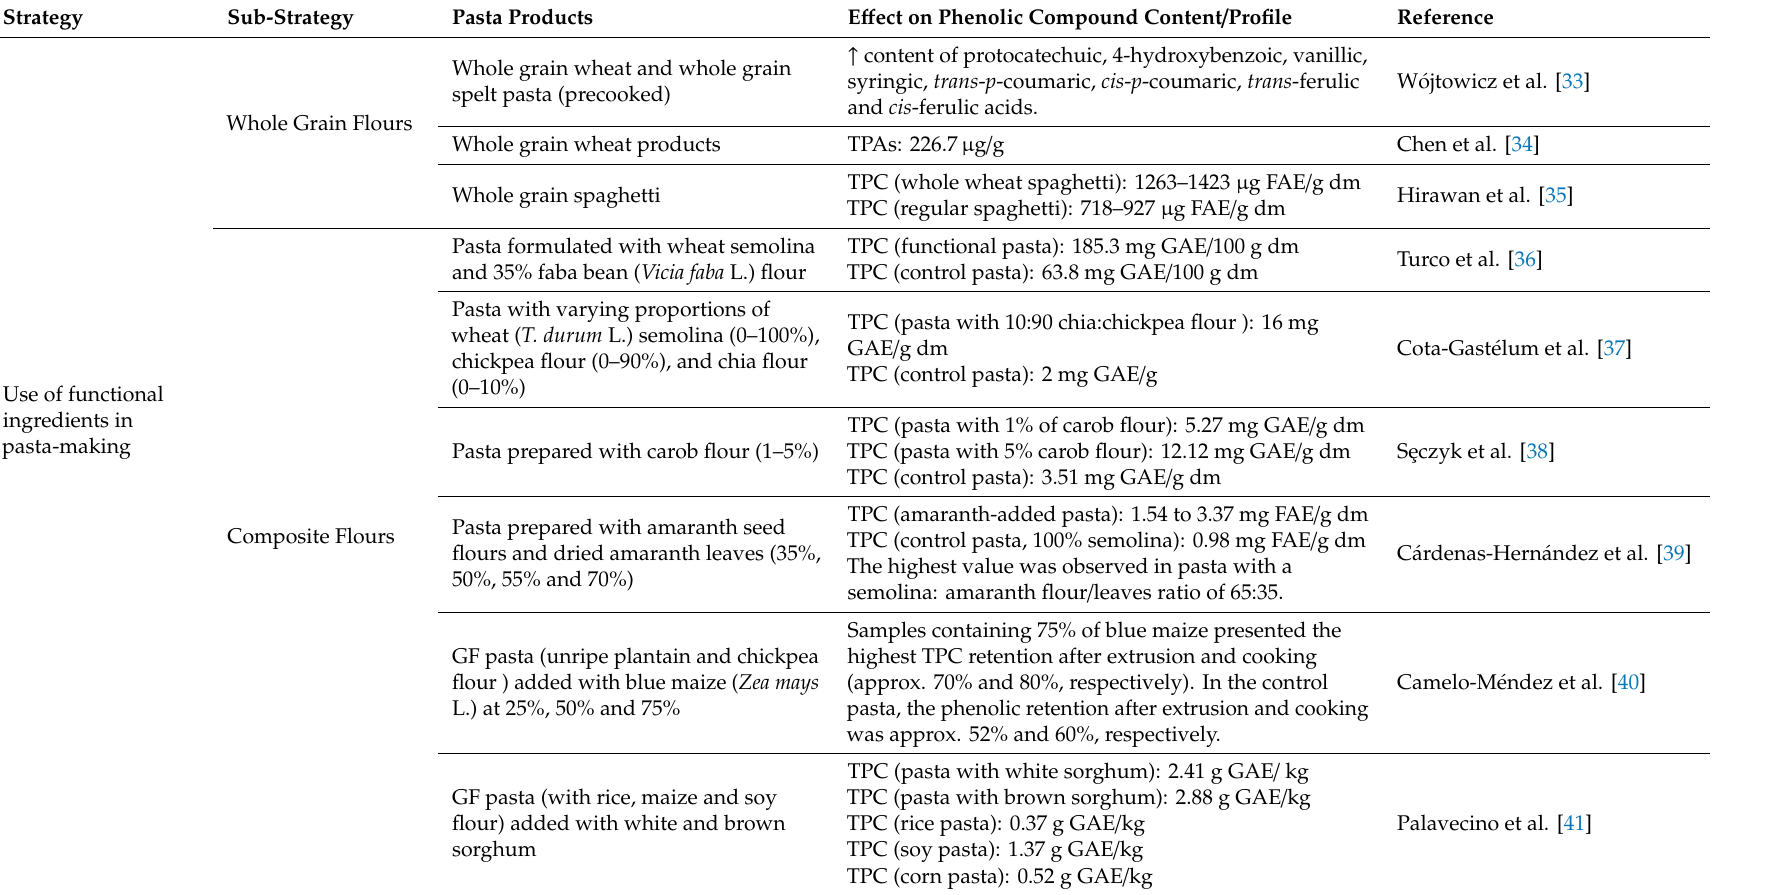
Table 2. Modulation of phenolic compound content in